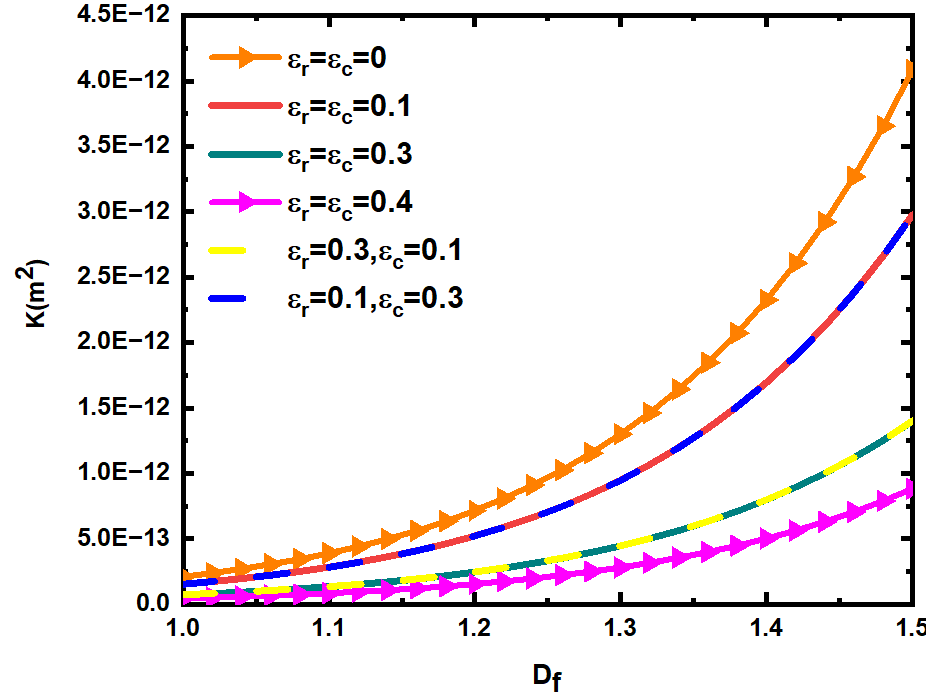
Figure 12. Relationship between permeability K of fractured dual porous media and fracture length fractal dimension D f with different relative